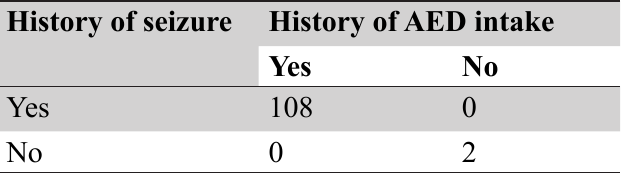
Table 2. History of seizure and use of anti-epileptic drug.